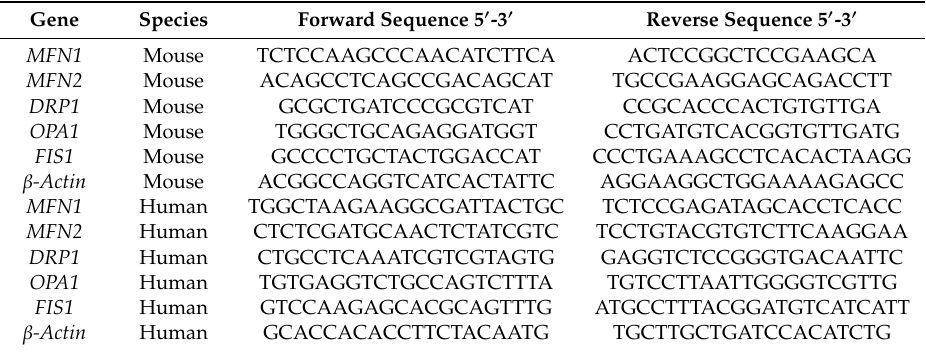
Table 1. Primer sequences for qRT-PCR.